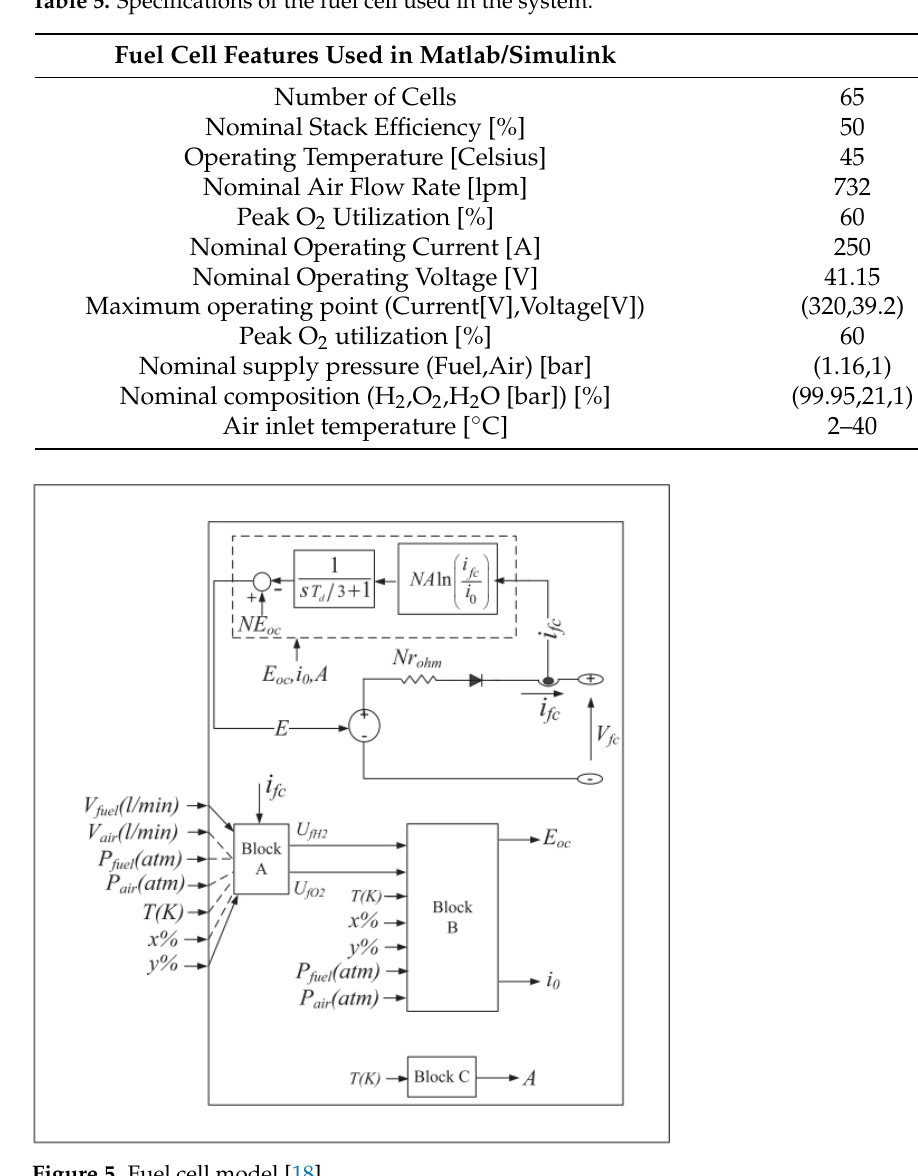
Figure 5. Fuel cell model